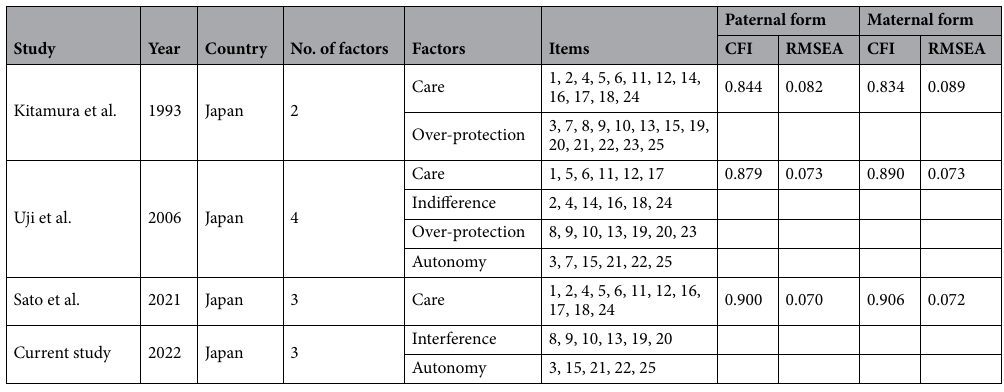
Table 3. Confirmatory factor analysis of the factor models of previous studies with the second set of PBI data (n = 2330).